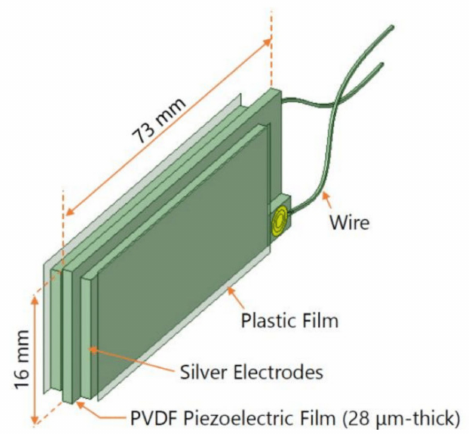
Figure 2. A schematic image of PVDF piezoelectric film (DT2-028K/L, Tokyo Sensor Co. Ltd.) which was utilized in the development of the respiration sensor [67].